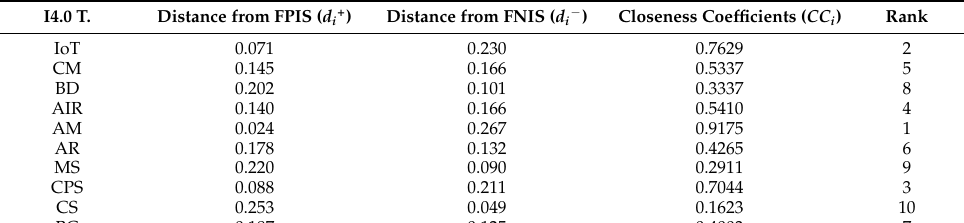
Table 8. Fuzzy TOPSIS result (distances and closeness coefficient). I4.0 T.